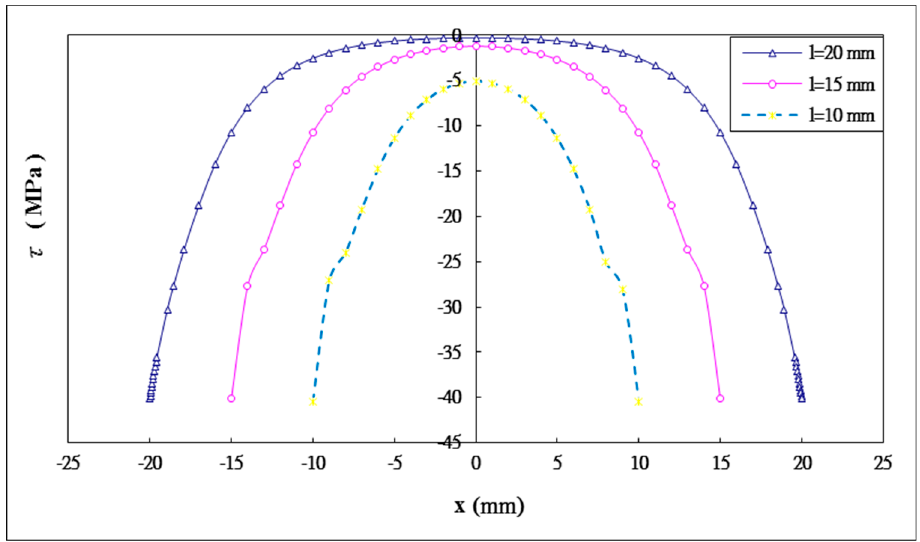
Figure 11. Shear stress distribution in the adhesive with three different bonding lengths.